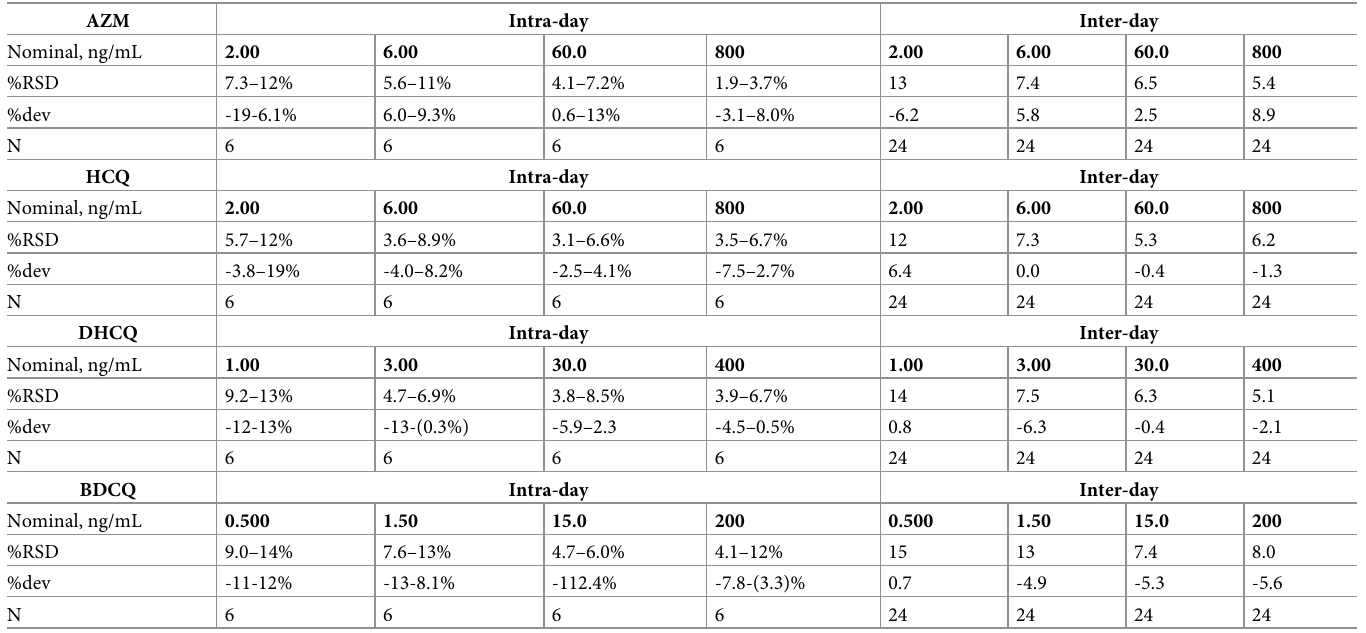
Table 4. Precision and